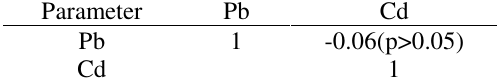
Table 7. Correlation matrix of vegetables Pb and